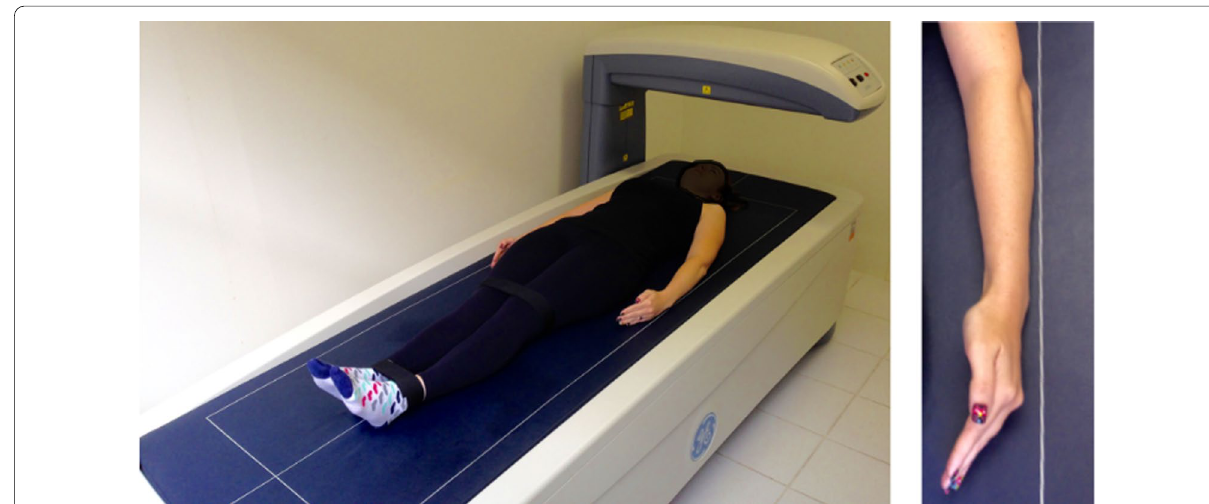
Fig. 8 Correct patient alignment according to the manufacturer of GE‑Lunar